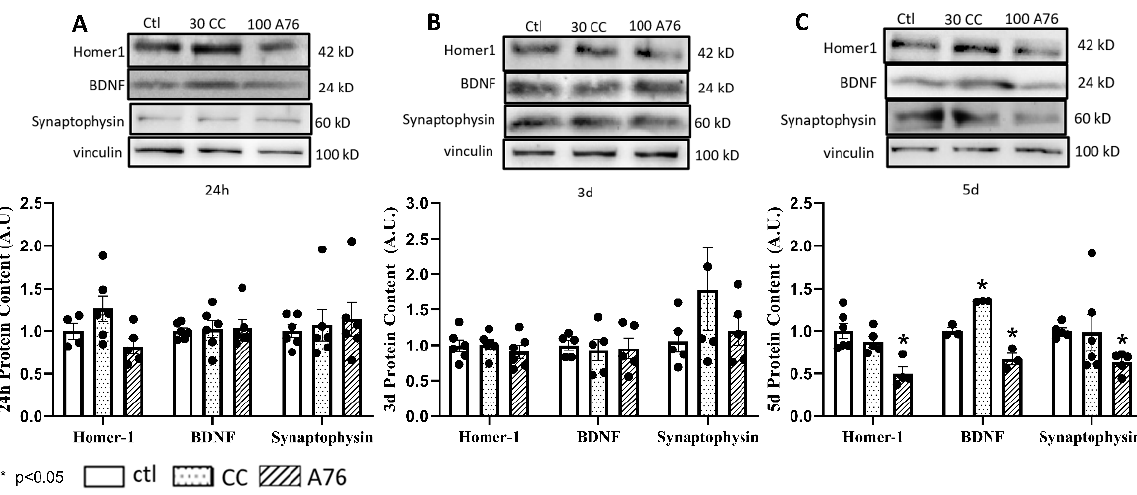
Figure 3. Chronic effects of Compound C (CC; dotted bars) and A-769662 (A76; hatched bars) on regulating cellular synaptic protein content. Western blot analysis for Homer-1, BDNF, and synaptophysin relative to control (open bars) in SH-SY5Y neuroblastoma cells following 24 h ( A ), 3 d ( B ), and 5 d ( C ) treatments of inhibitor Compound C (30 n M) and AMPK activator A-769662 (100 n M). Representative Western blots provided above. Results represent independent experiments (N = 3–6; Black Circles). Data are presented as mean ± SEM. * Indicates significant ( p < 0.05) difference from ctl as determined using a one-way ANOVA followed by Tukey’s post hoc analysis.